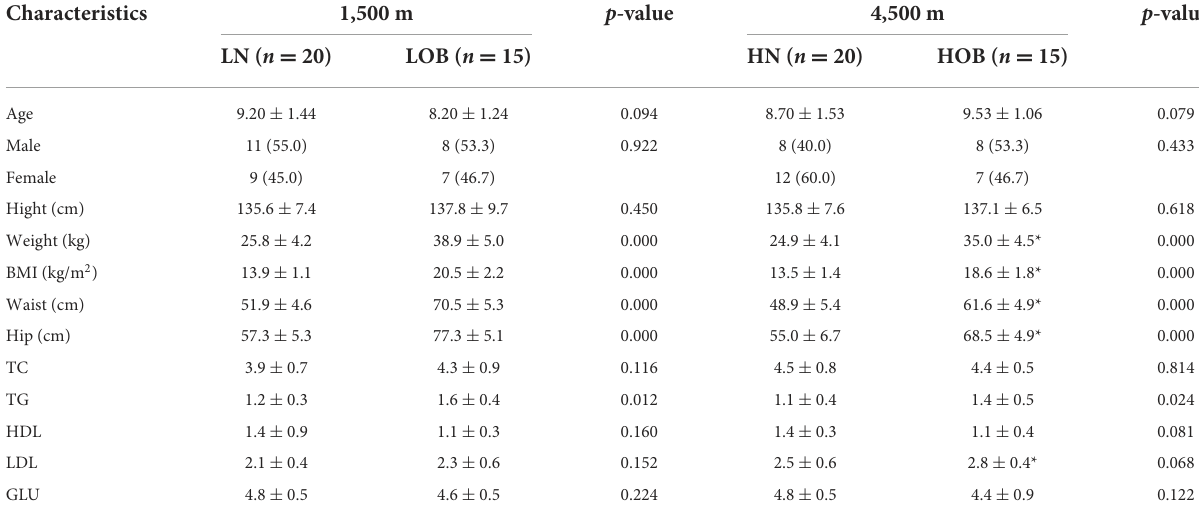
TABLE 1 Characteristics of the participants by altitude.